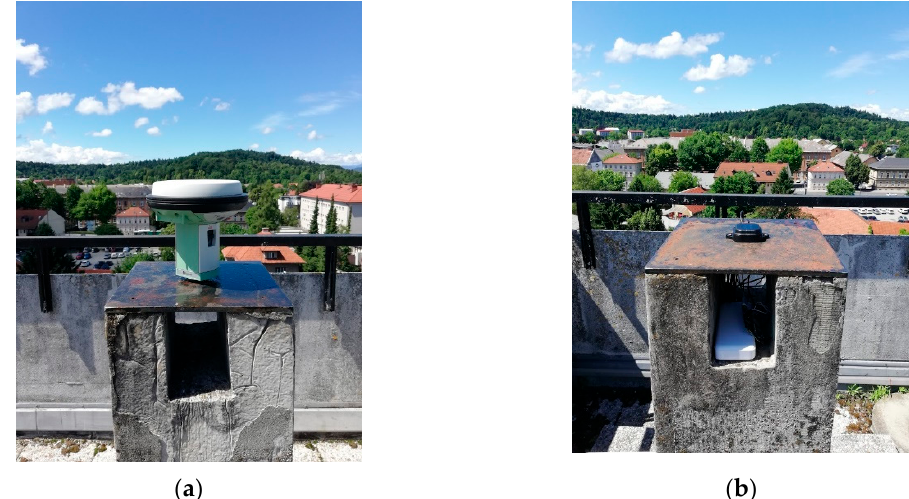
Figure 3. GNSS receivers: ( a ) Reference station Leica GS 15 in pillar FGG2; ( b ) Rover ZED-F9P in pillar FGG1.